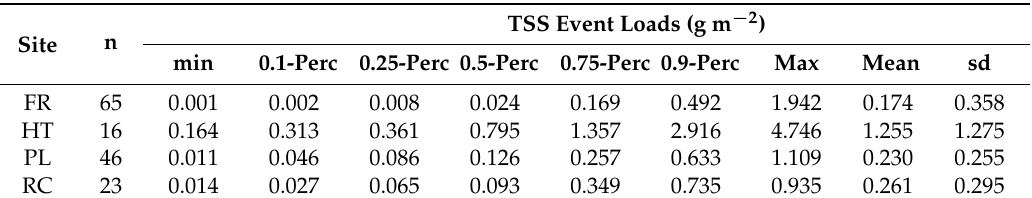
Table 1. Descriptive statistics (min, 0.1-, 0.25-, 0.5-, 0.75-, 0.9-percentiles, max, mean, standard deviation) of site-specific Total Suspended Solids (TSS) event loads (FR: Flat Roof, HT: High Traffic Street, PL: Parking Lot, RC: Residential Catchment).